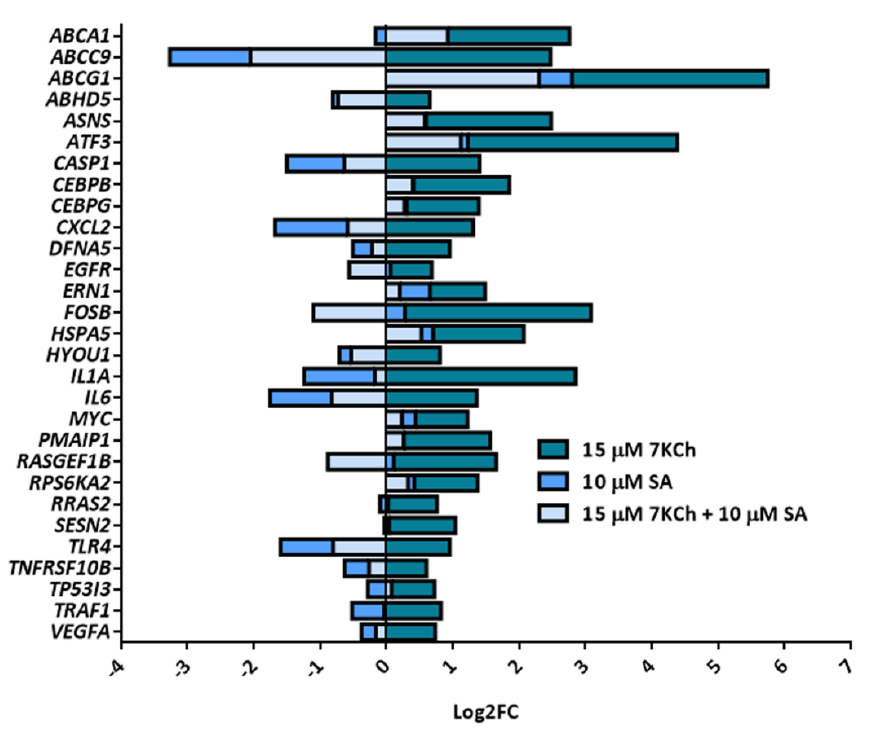
Figure 3. Reversion effect induced by 10 μM SA over several representative genes altered by 15 μM 7KCh. Y -axis shows examples of genes modulated by 7KCh, whereas the X -axis represents the change in the expression of these genes in mRPE cells treated with 15 μM 7KCh, 10 μM SA or with the combination of SA and 7KCh with respect to the control and expressed as Log2FC. Positive Log2FC represents upregulated genes, while negative Log2FC represents downregulated genes. SA gene modulation data were obtained from our previous work [39].